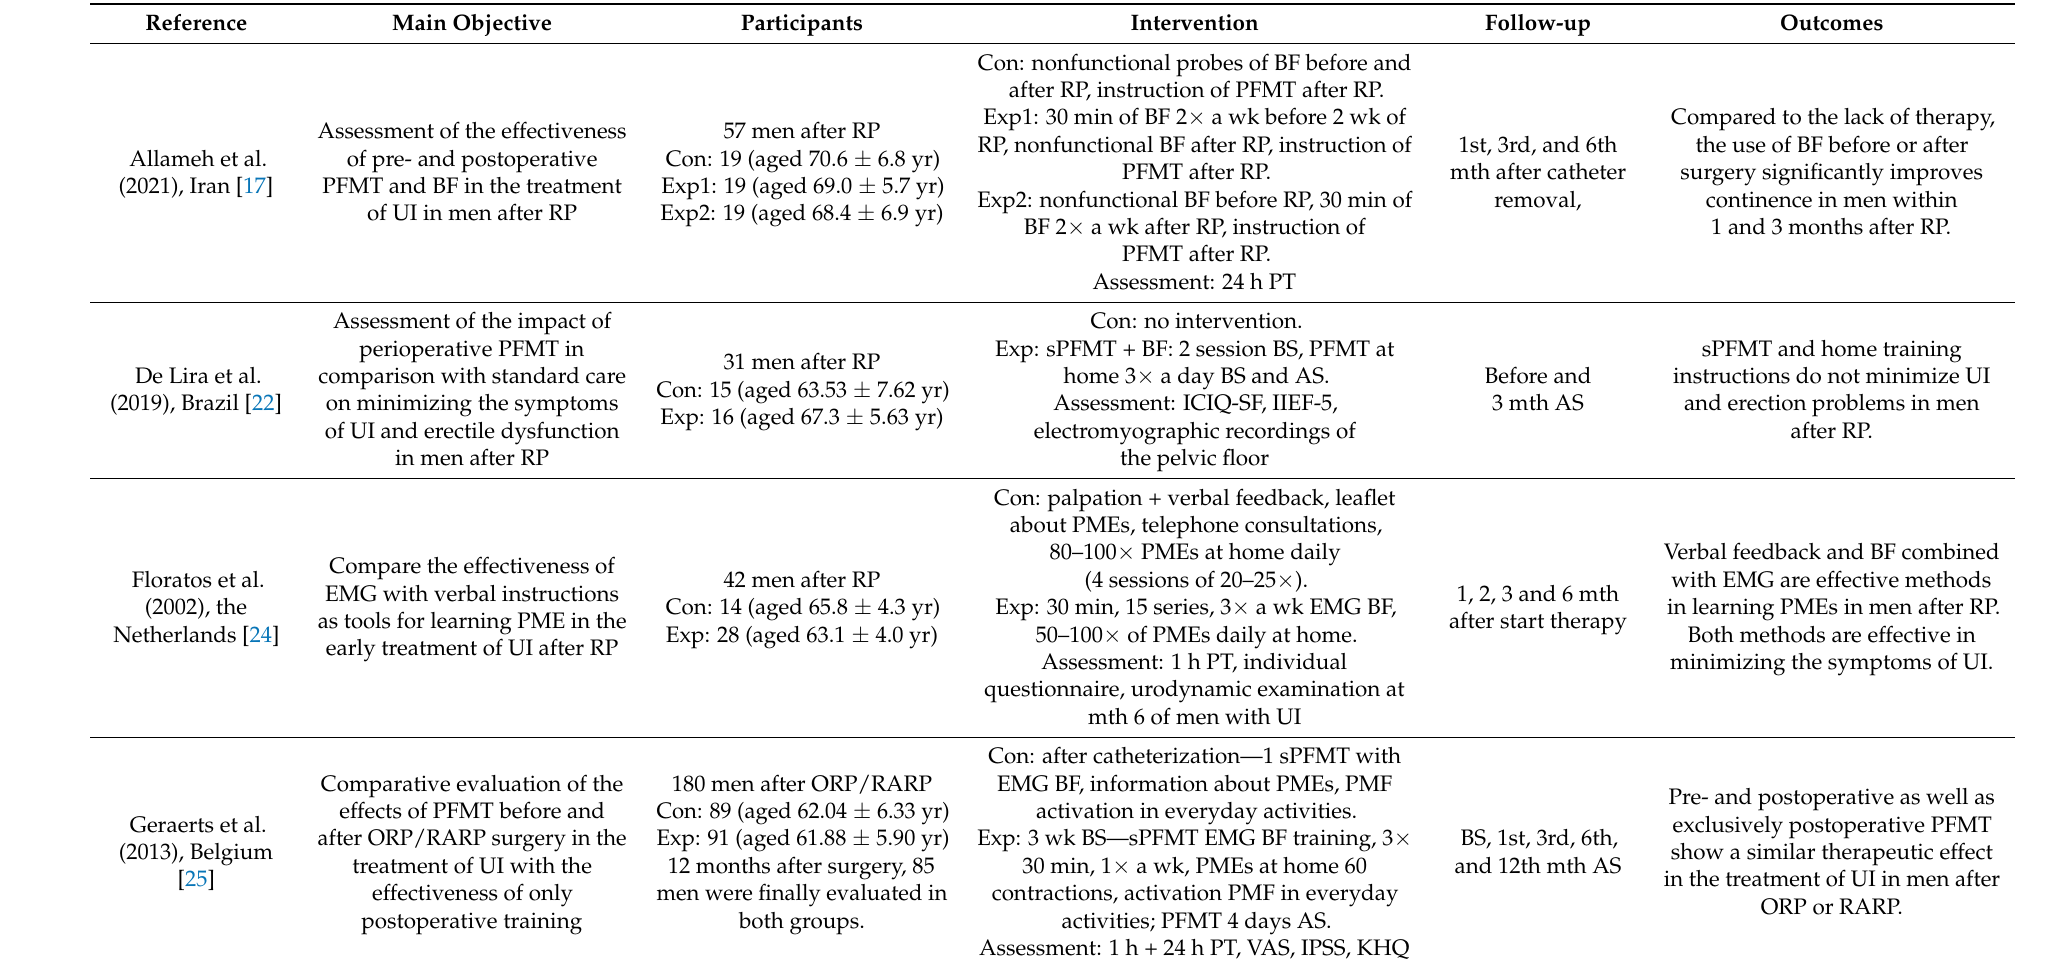
Table 3. PFMT training with BF in men with UI after